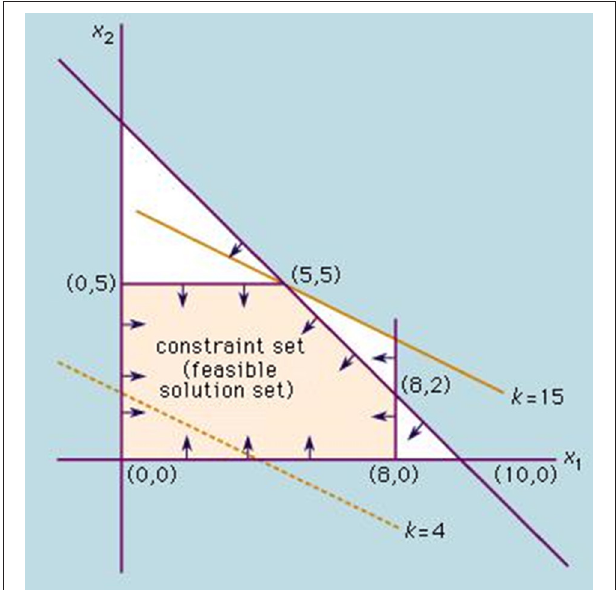
FIGURE 1 | Concept of linear programming: The constraints (x i ; purple lines) result in a feasible solution set (yellow area). The objective function (k; yellow line) results in the highest possible solution at the edge of the solution